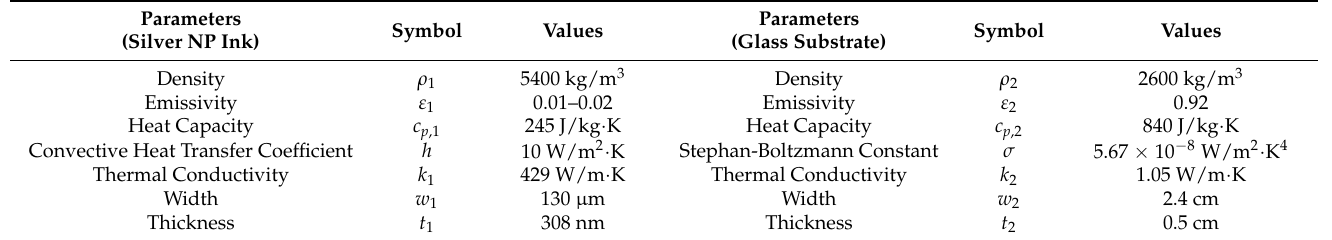
Table 1. Parameters used in the numerical calculations.